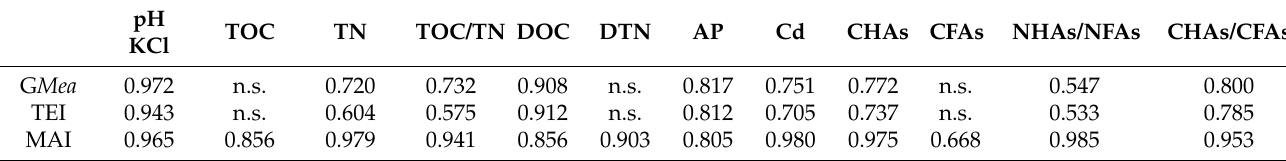
Table 7. The correlations between selected soil parameters and soil quality indexes.